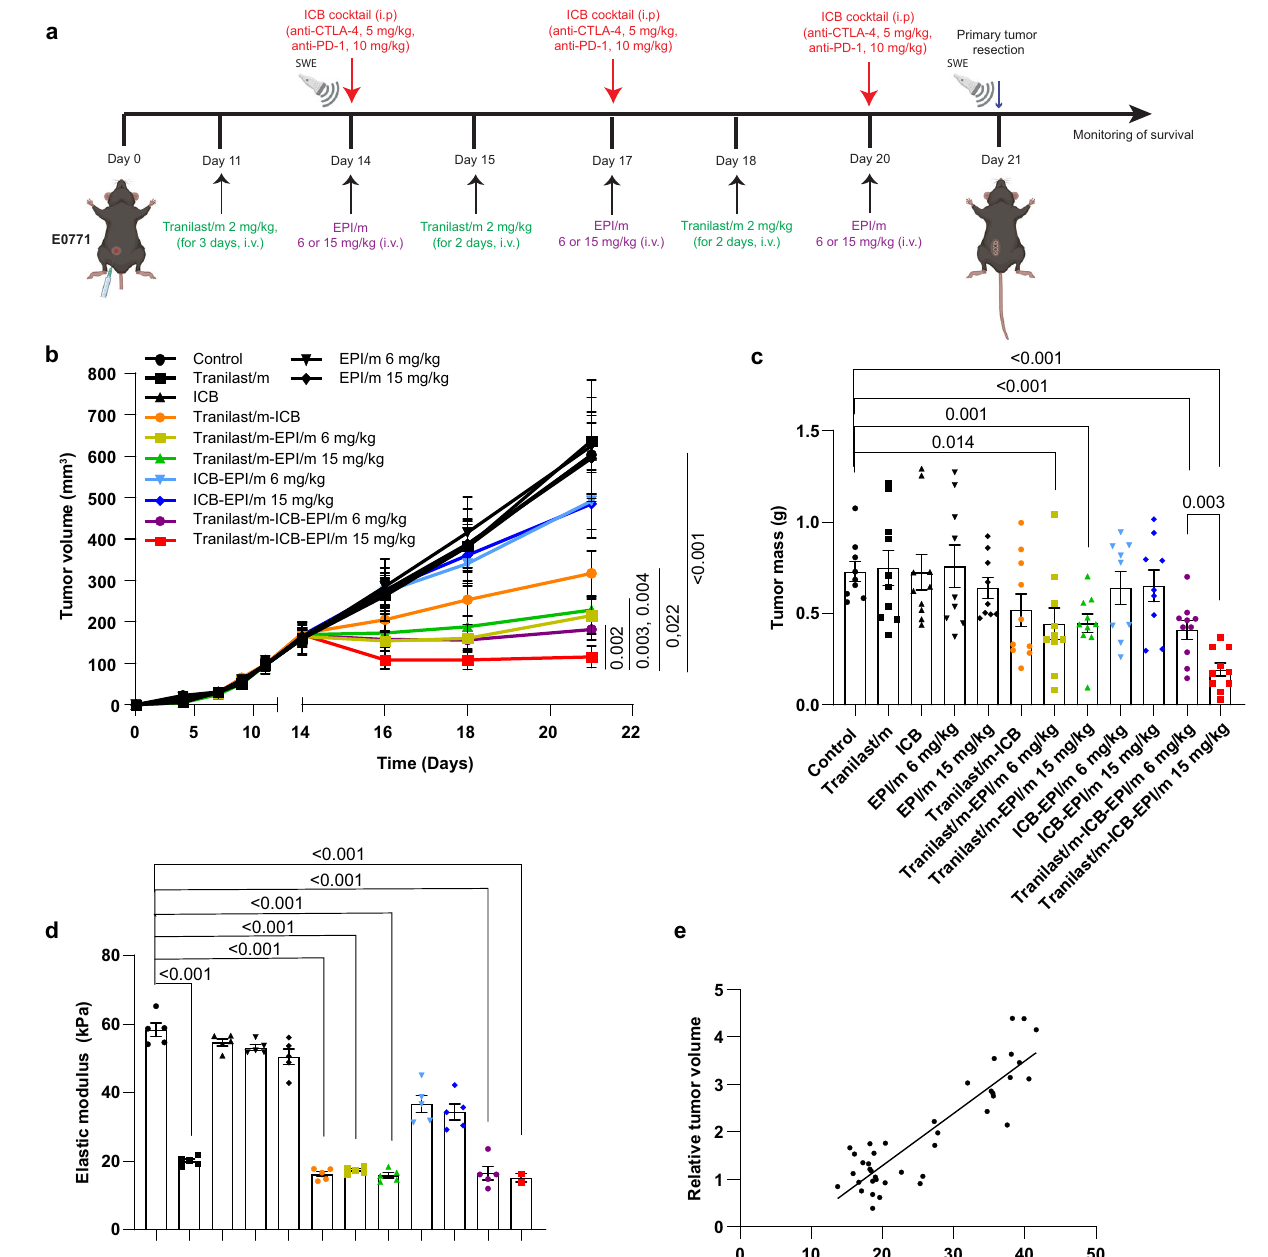
Fig. 4 | Tranilast micelles signi fi cantly improve the ef fi cacy of nano- immunotherapy.a Studytreatmentprotocolfortheeffectoftranilastmicelleson nano-immunotherapy.Tumorvolume( b )andmass( c )ofE0771tumors.Both6and 15mg/kg of EPI/m chemotherapy exhibited a signi fi cant antitumor effect when combined with immunotherapy and tranilast treatment ( n =10 mice). d Tumor elastic modulus values measured with ultrasound elastography at the completion of the treatments (day 21). ( n =5 mice, N =2 image fi elds per mouse). Data are